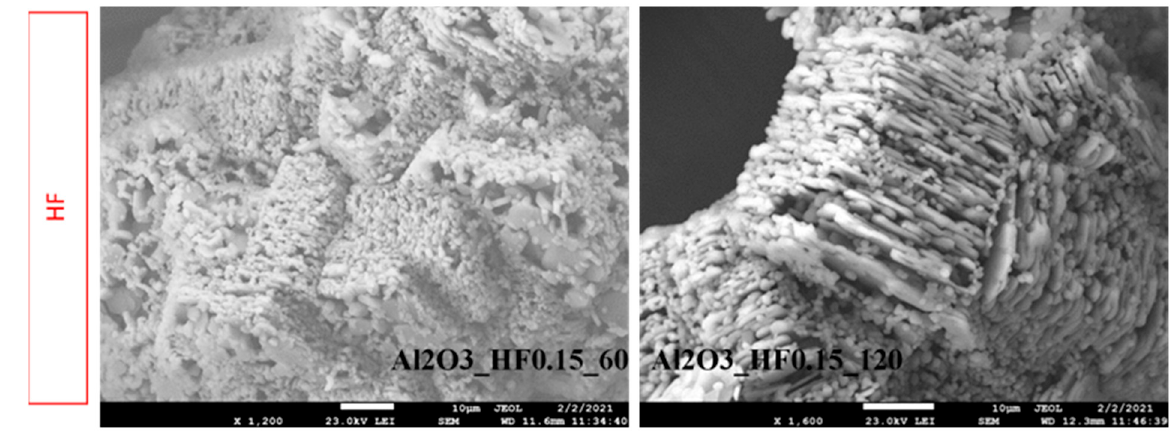
Figure 3. SEM images comparing the degree of agglomeration of alumina powders after etching with different acids.